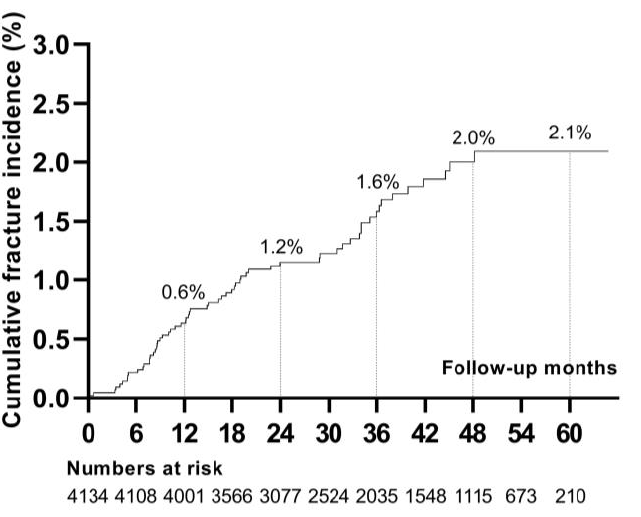
Figure 1. Cumulative incidence of fractures after kidney transplantation.